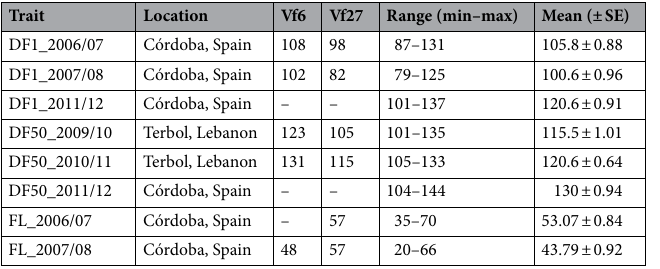
Table 1. Phenotypic values (mean ± SE) of days to first flower (DF1), days to 50% of flowering (DF50) and flowering length (FL) for parental and RILs from the cross Vf6 × Vf27 in each location and agronomic season.